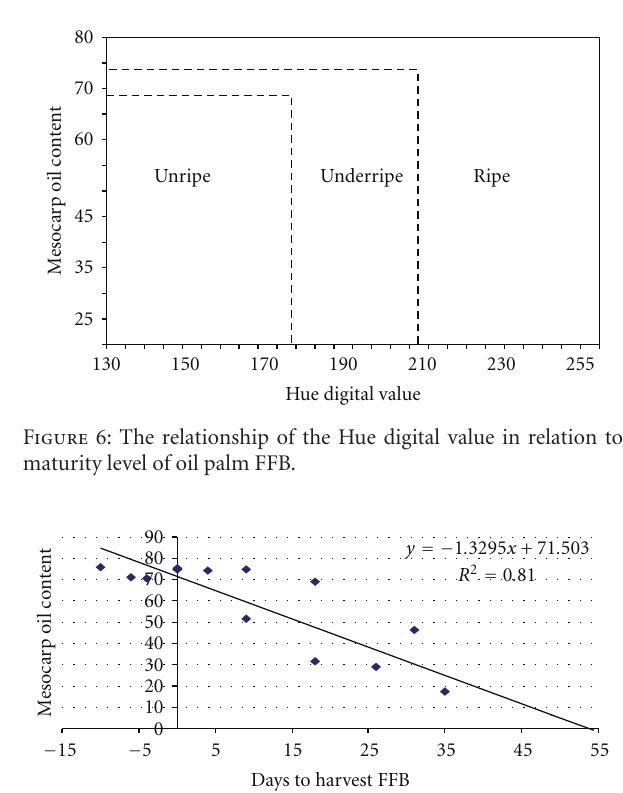
Figure 7: Estimation model of mesocarp oil content for harvesting date prediction.